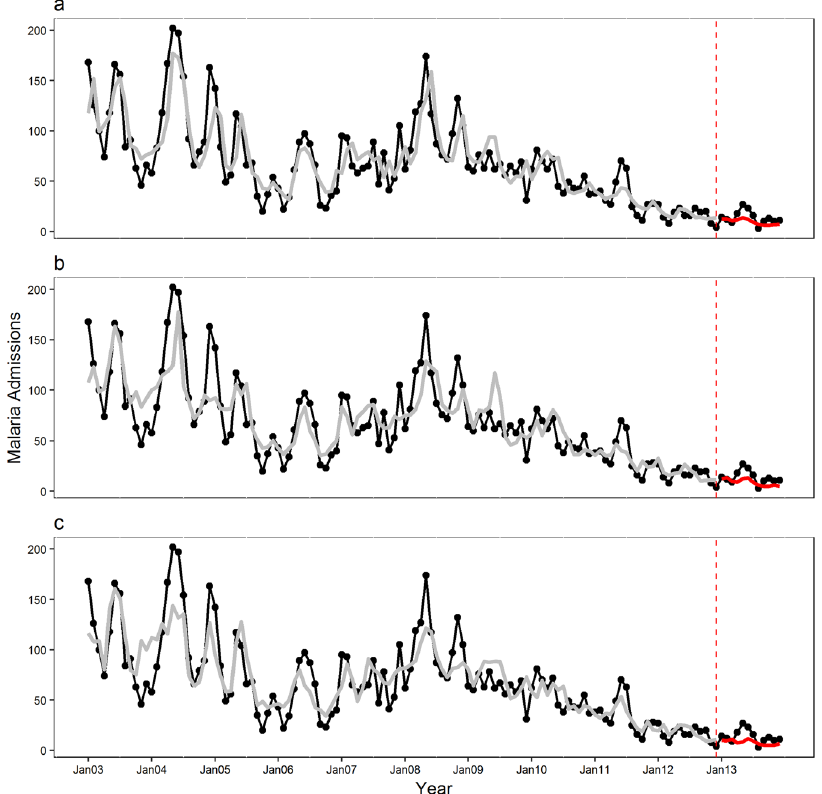
Figure 4. Observed and predicted pediatric malaria admissions at Siaya district hospital, Western Kenya by prediction lead time for the period 2003–2013 from the GAM model. ( a ) The 1-month, ( b ) the 2-month and ( c ) the 3-month prediction lead times respectively. The black line displays observed malaria admissions, the grey line predicted values during the training period 2003–2012, and the red line the 2013 forecasted values. The dotted red line marks the beginning of the test period.